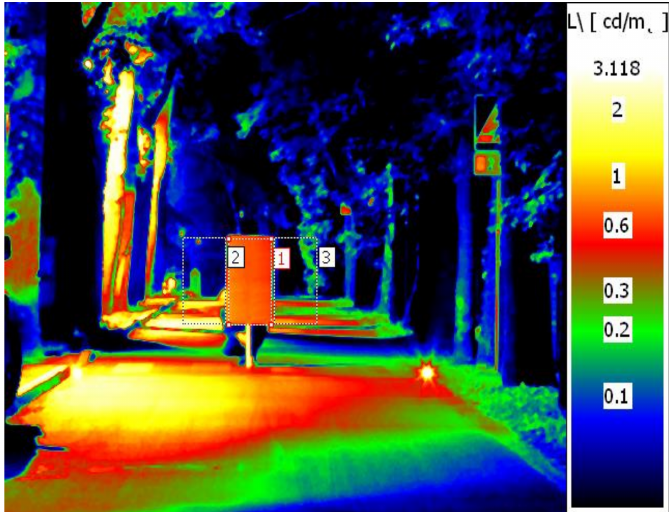
Figure 17. Luminance distribution for example position of the board at crossing no. 1.